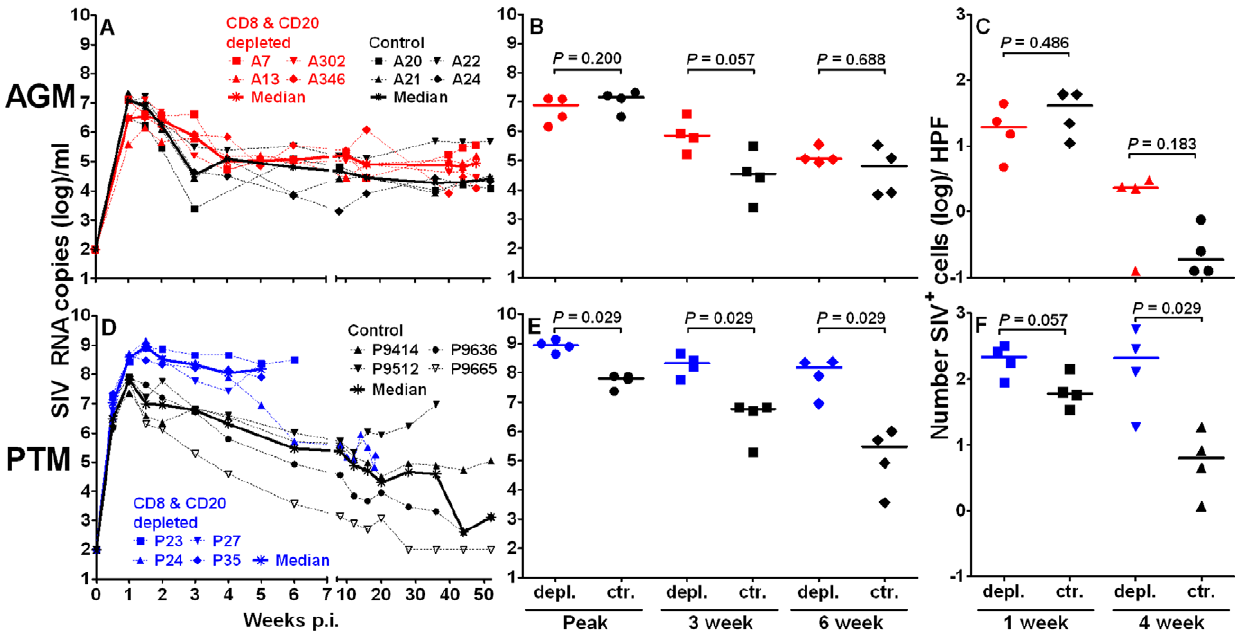
Figure 3. CD8 + and CD20 + lymphocyte depletion has a greater effect on SIV peak viremia and lymphatic tissue viral load in PTM than in AGM. Plasma SIV RNA copies/ml are shown for vervet AGM ( A, B ) and for PTM ( D, E ). Number of SIV RNA expressing cells in lymph node biopsies of anti-CD8 and anti-CD20 treated and historic control AGM ( C ) and PTM ( F ) at one and four weeks p.i. The median number of SIV positive cells is given for each animal and was quantified for six high power fields (HPF). CD8 + and CD20 + lymphocyte-depleted animals are plotted in color symbols (red symbols for vervet AGM and blue symbols for PTM) and historic control animals in black symbols.